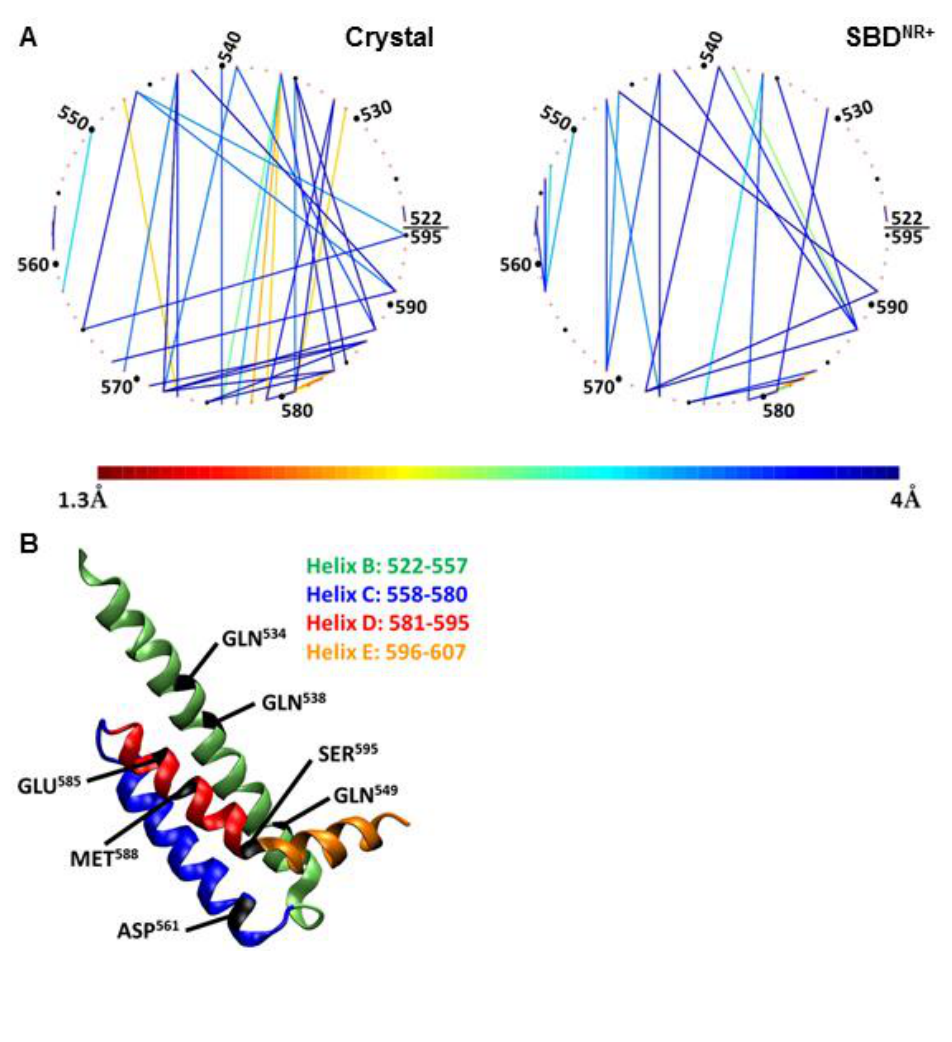
Figure 7. Interconnectivity network for helices B, C and D in SBD NR+ simulation. Frame A depicts the average distance between selected residues on helices B, C and D. Each residue is represented as a single dot on the circle and the distance to nearby residues is marked by a line whose color corresponds with the geometric mean of the minimal distance between the residues during the last 10 ns of the simulation time (see the color bar). The left panel represents the distances between the residues in the crystalline state of the protein, while the right panel represents the geometric mean of the minimal distance between two residues during the last 10 ns of the simulation. Only pairs for which the mean distance is less than 4 Å are shown. Frame B is a cartoon representation the structure of the lid with the residues marked in frame A. The helices are colored as in Figure 1. The limits of each helix are presented in the